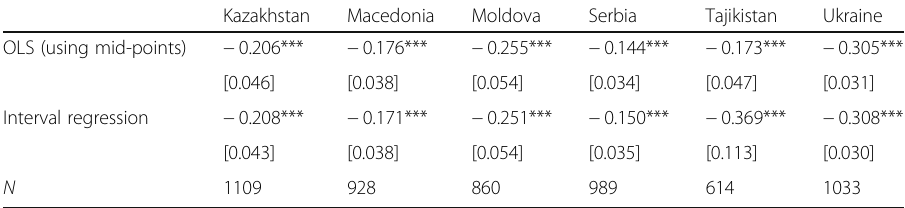
Table 5 Estimated gender coefficients from gender dummy, only. Estimations: OLS and interval regression Kazakhstan Macedonia Moldova Serbia Tajikistan Ukraine OLS (using mid-points) − 0.206*** − 0.176*** − 0.255*** − 0.144*** − 0.173*** − 0.305*** [0.046] [0.038] [0.054] [0.034] [0.047] [0.031] Interval regression − 0.208*** − 0.171*** − 0.251*** [0.043] [0.038] [0.030] N 1109 928 860 989 614 1033 Notes: Values in brackets are within-community correlation/clustering adjusted standard errors (Wooldridge 2010) (and therefore also (implicitly) robust (Huber 1967; White 1980)). Source : UNDP/UNICEF Social Exclusion Dataset 2010 (collected November – December 2009) *Statistically significant at 10%; **statistically significant at 5%; ***statistically significant at